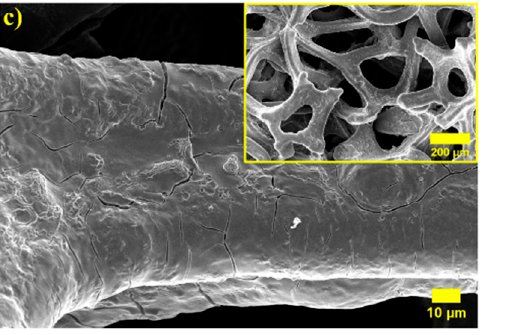
Figure 8. Post-mortem SEM images after 100 cycles of ( a ) NiO/Ni@PAN-(PAN-PVA)-PVA, ( b ) NiO/Ni@PAN-(PAN-PVA)-PVA with 0.25 wt% Al 2 O 3 and ( c ) NiO/Ni@PAN-(PAN-PVA)-PVA with 0.5 wt% Al 2 O 3 .